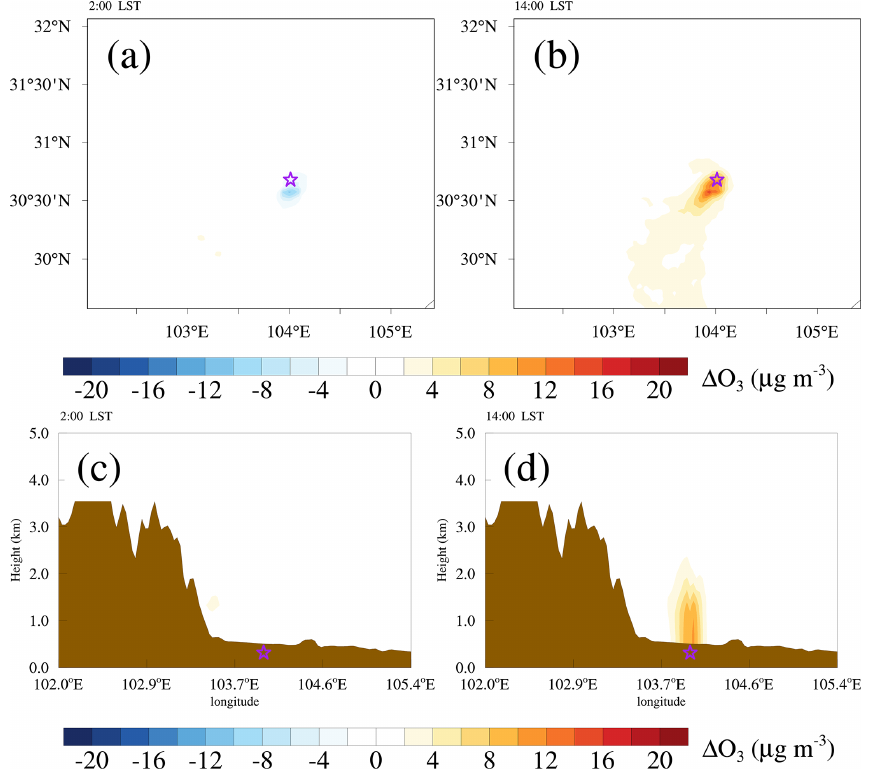
Figure 12. Same as Fig. 10 but for the difference between the monthly average of the July_Base and July_noEmi simulations (July_Base minus July_noEmi).